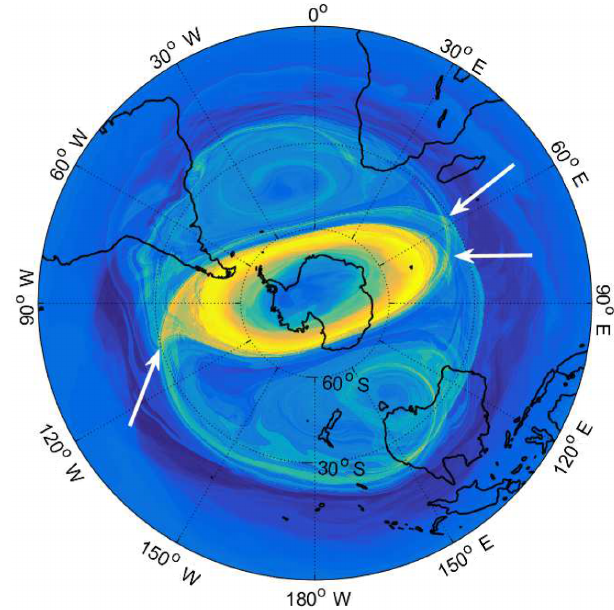
Figure 1. Stereographic projection of Lagrangian descriptors eval- uated using τ = 15 on the 850K isentropic level for 5 August 2002 at 00:00:00UTC. The SPV is clearly visible, as well as three hy- perbolic trajectories (HTs) outside the vortex (marked with white arrows), two northeast and one southwest of it. Filamentation phe- nomena, which occur in the neighbourhood of HTs, are visible both inside and outside the vortex, where the outer filamentous structures play the role of eroding the jet barrier. Notice also the presence of two eddy-coherent structures over the South Atlantic and south of